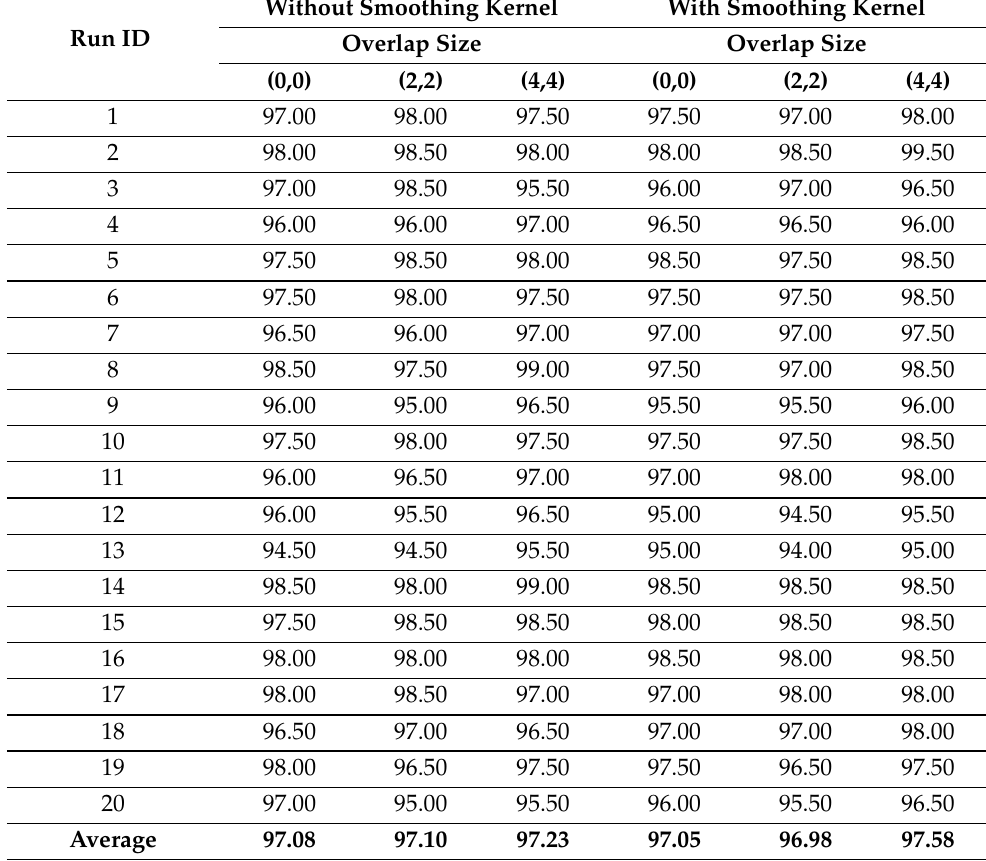
Table A10. The results of the runs for Salt and Pepper noise with density of